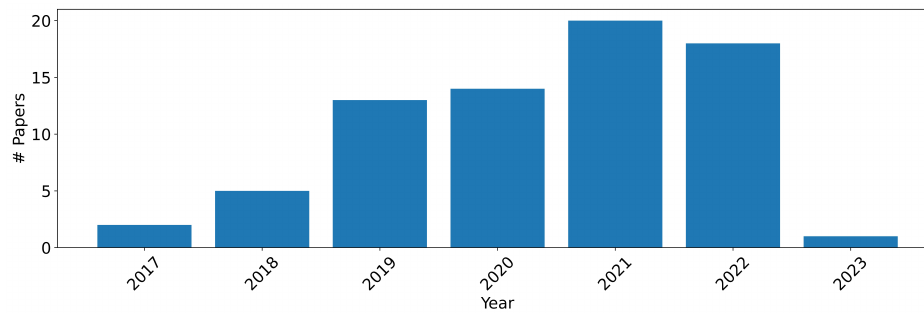
Figure 8. Paper count by